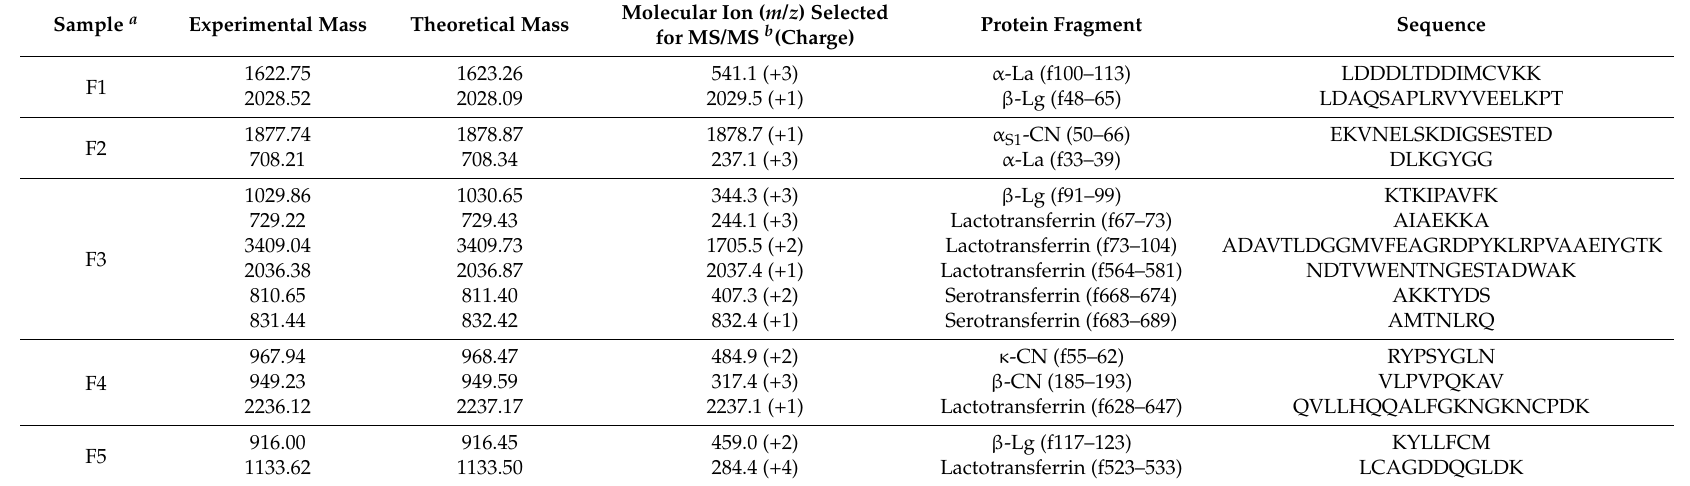
Table 1. Identification of peptides in the water soluble fraction (<10 kDa) obtained from milk fermented by Lactobacillus fermentum J28. Sample